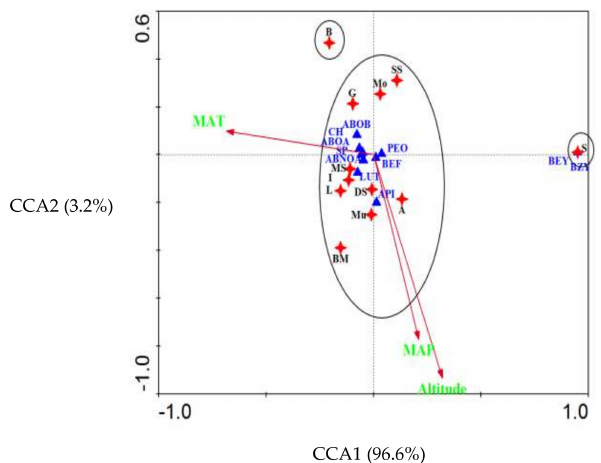
Figure 5. Canonical correspondence analysis (CCA) biplot of Matricaria chamomilla populations, linking percentages of the major constituents, collected from different environmental conditions. Populations